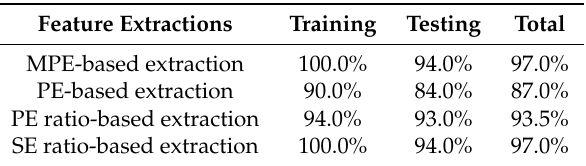
Table 7. Accuracy rate considering the effect of the feature extraction methods. MPE, multiscale permutation entropy; SE, Shannon entropy.